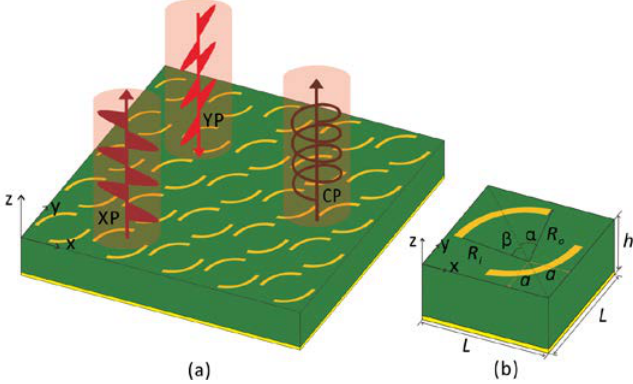
Figure 1. Design of the polarizer, ( a ) 5 × 5 unit structure diagram, ( b ) A unit cell diagram.